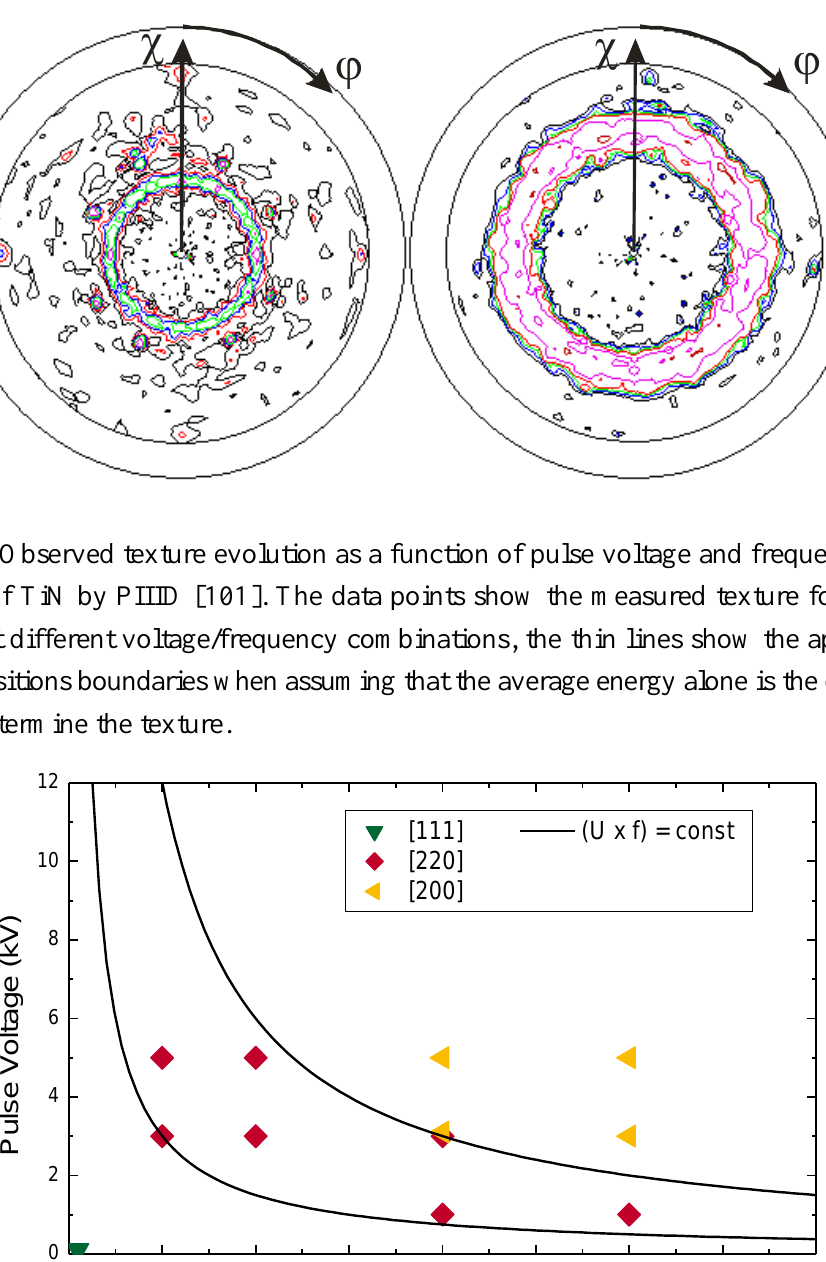
Figure 10 . Depiction of TiN {110} and {200} fiber texture, as obtained from {111} pole figures, for plasma immersion ion implantation and deposition (PIIID) at different pulse voltages of (a) 1 kV and (b) 10 kV at fixed duty cycle of 9% [100].